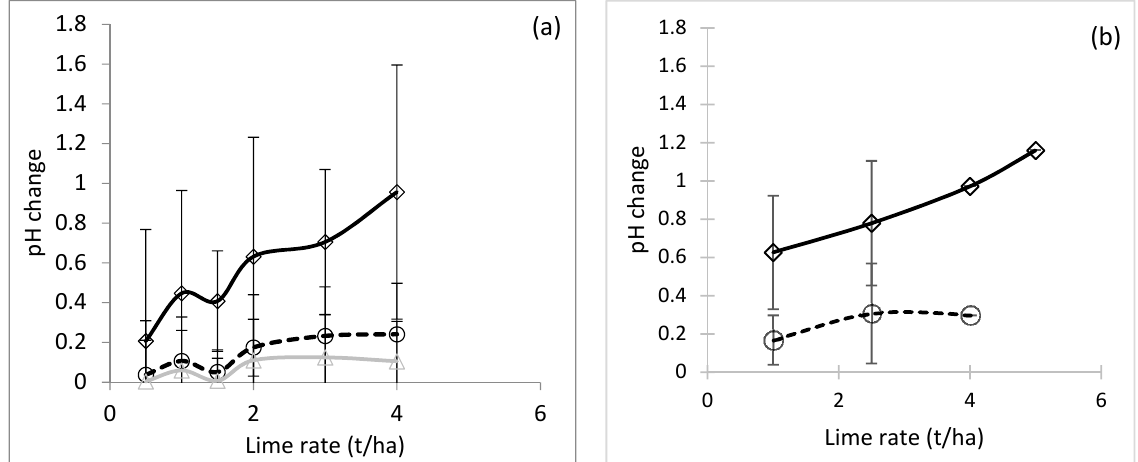
Figure 3. Change in soil pH (CaCl 2 ) after liming in the 0–0.1 m ( ♦ ). 0.1–2 m (o) and 0.2–0.3 m ( ∆ ) layers with lime rate in WA cases ( a ) and NSW and Victoria cases ( b ). Error bars indicate +/ − 1 standard deviation.